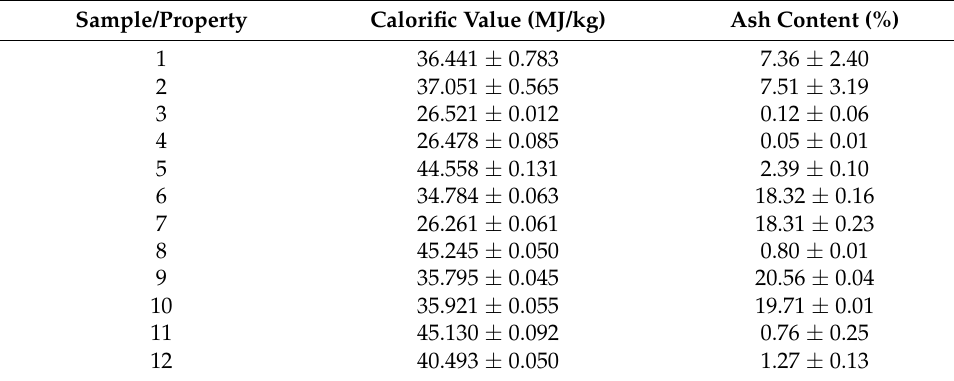
Table 3. Calorific values and ash content of wastes tires and